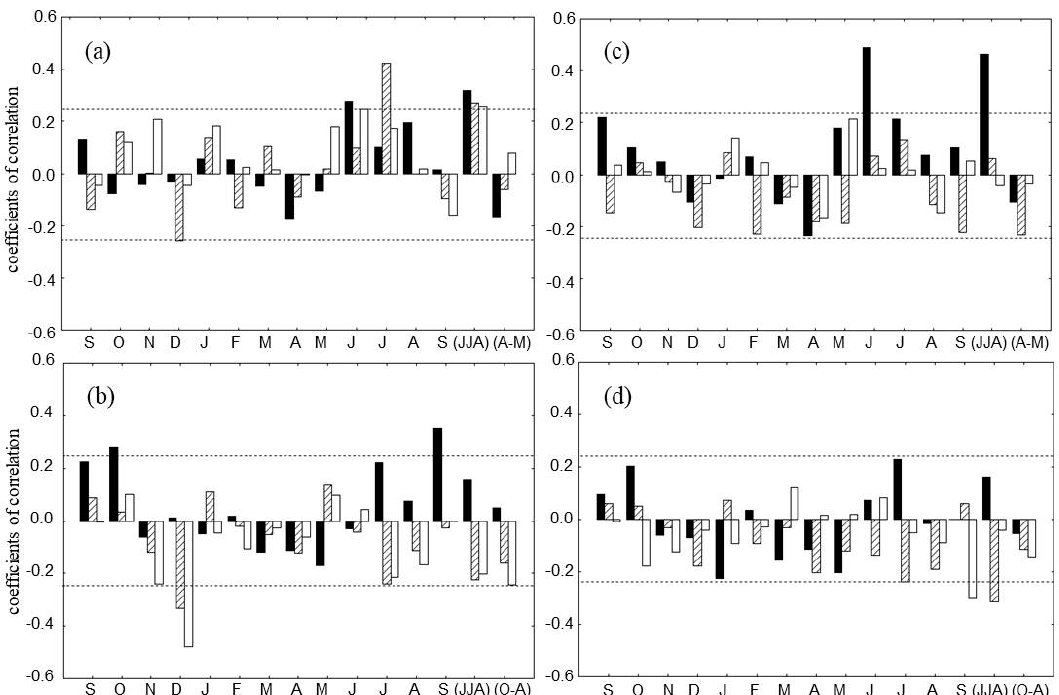
Figure 6. Tree responses to climate in DS (left panels) and WS (right panels) for the period 1936–2005. The relationships with climate are based on Pearson correlation coefficients between tree-ring data corresponding to each site and mean temperature ( a , c ) and total precipitation ( b , d ). Climate signals are investigated at monthly (previous September to current September) and seasonal time scales. For seasonal analysis we used mean of summer (June–August, JJA) and spring (April–May, AM) temperatures and sum of summer (JJA) and winter (October–April, O–A) precipitation. Tree-ring traits are represented by black (TRW chronology), hatched ( δ 13 C Cell ), and white ( δ 18 O Cell ) bars. The horizontal dotted lines indicate the threshold for significance at p < 0.05 (r = 0.24, n = 70).